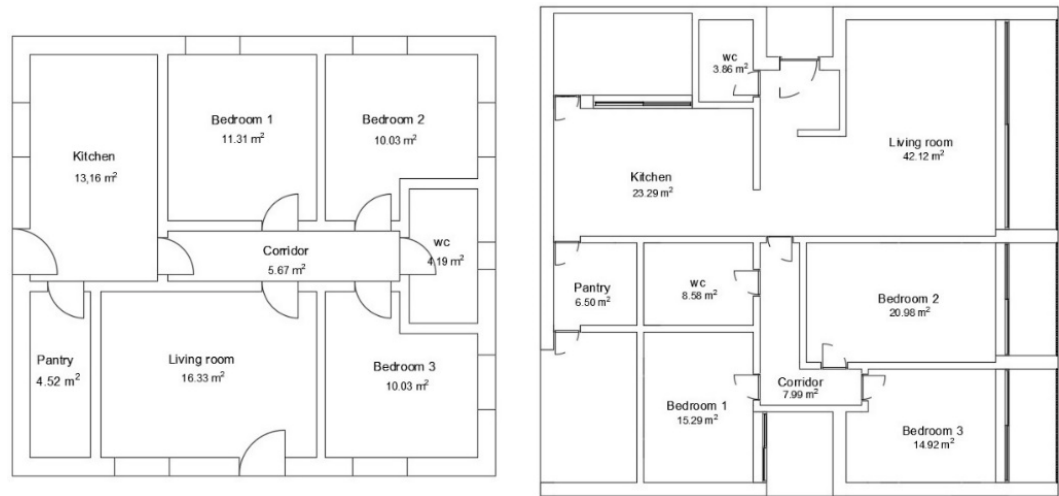
Figure 2. Floor plan of the case studies: existing model and new building model .